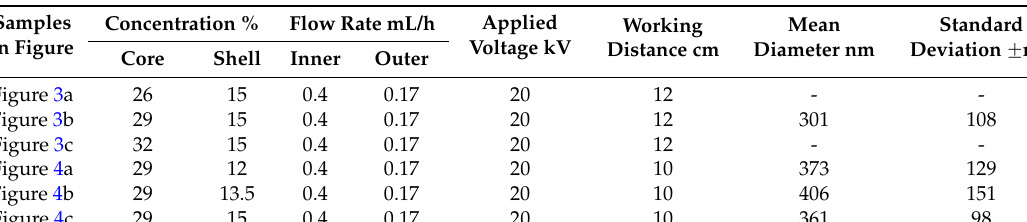
Table 1. Process parameters and statistical analysis of nanofiber diameters obtained from the field emission scanning electron microscopy (FE-SEM) images (sample size N = 100).